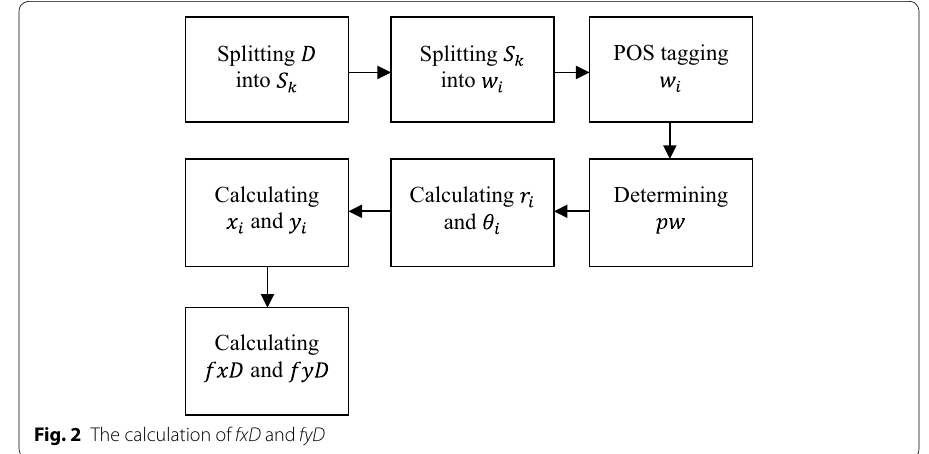
Fig. 2 The calculation of fxD and